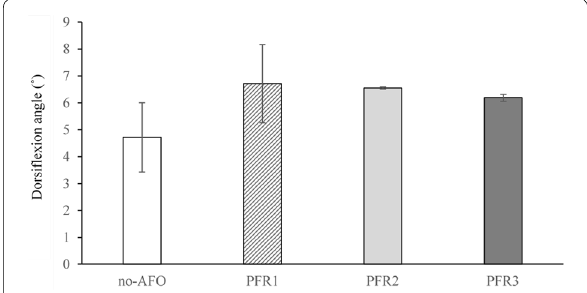
1 Fig. 6 Internal ankle joint torque in stance phase. Dorsiflexion is ± defined as positive. The % stance phase means time normalized to stance phase, from heel contact to toe off